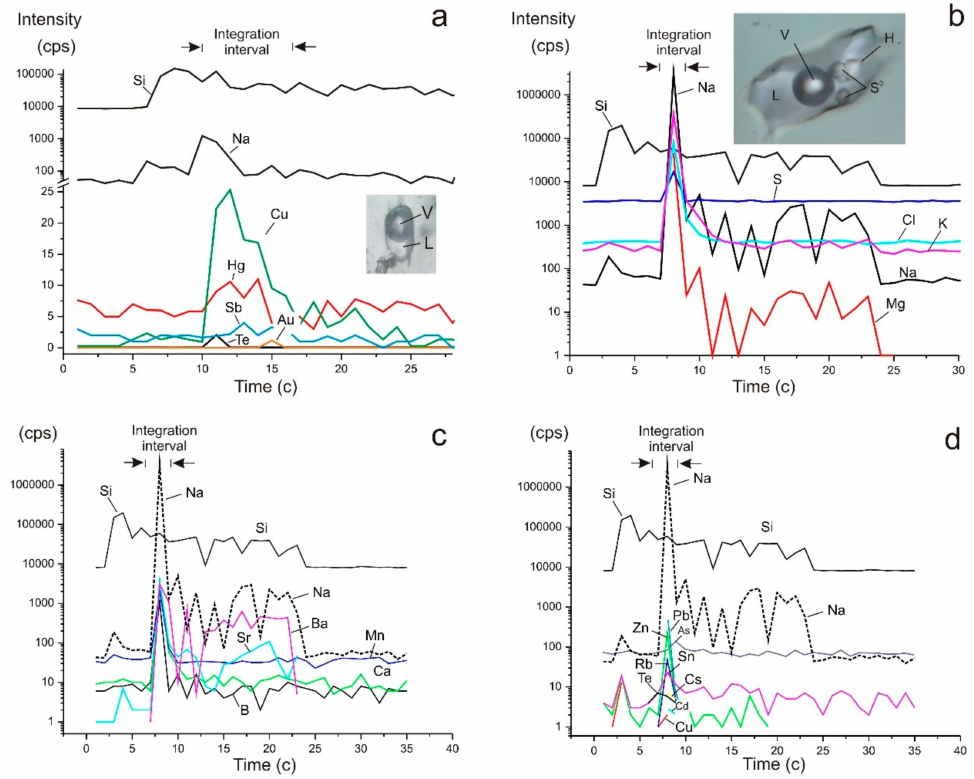
Figure 9. Sketches of the dependence of the signal intensity on time during ablation of a single fluid inclusions S1 / 10(2) ( a ) and SV (1) ( b – d ) (in Table 4). The photographs ( a , b ) show individual phases